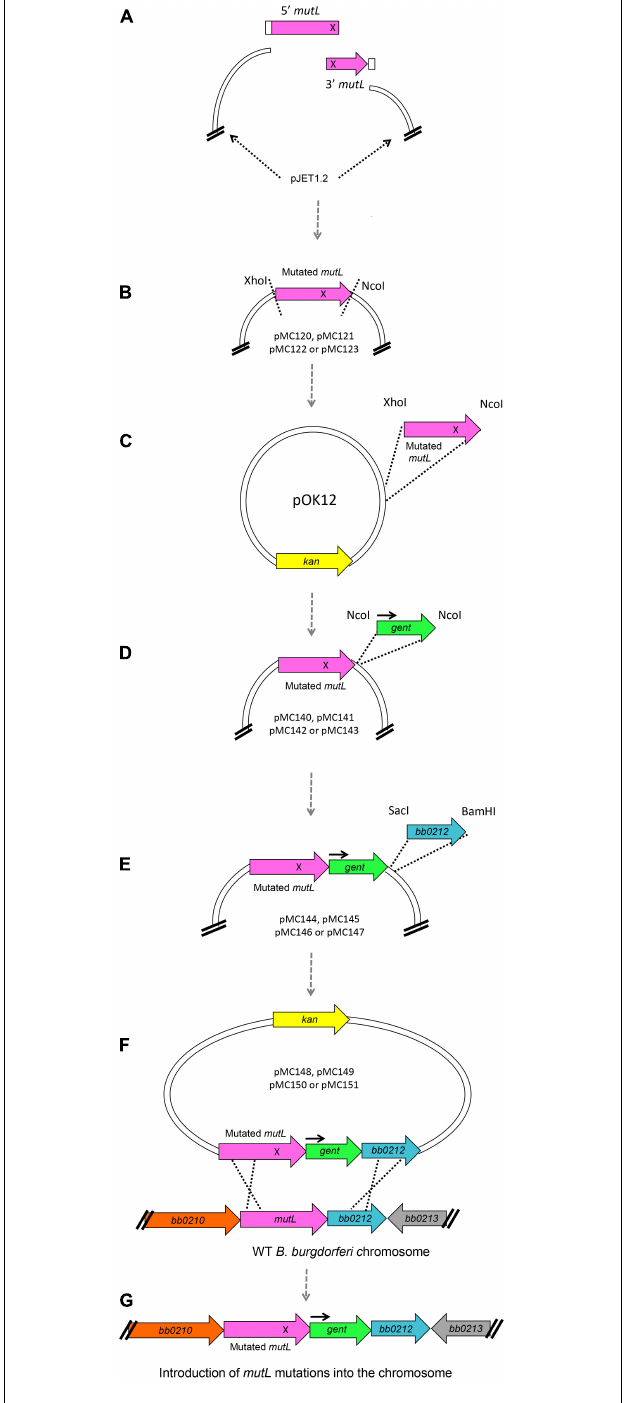
FIGURE 7 | Schematic of plasmid construction and introduction of point mutations into B. burgdorferi chromosomal mutL . (A) To generate the E. coli plasmids carrying point mutations in mutL we designed a two-insert strategy where two mutL double stranded fragments carrying complementary base pair changes (represented as an X) were ligated with each other and to pJET1.2 using the HiFi DNA Assembly mix from NEB. This assembly mix contains a 5 (cid:48) -3 (cid:48) exonuclease that generates single stranded 3 (cid:48) overhangs.